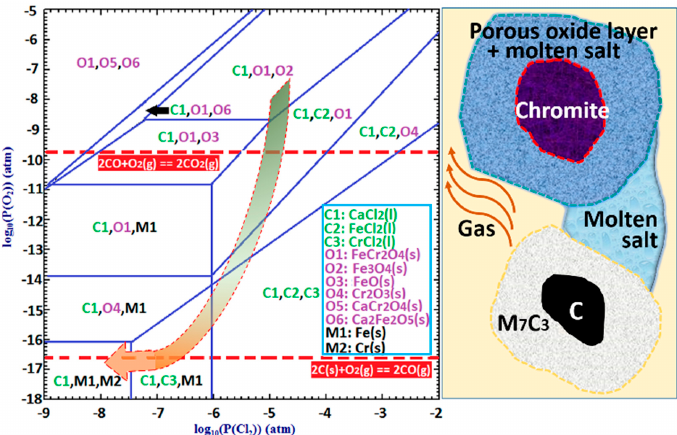
Figure 17. The presence of molten and/or gaseous CaCl 2 in the sample mixture maintained the chloridizing atmosphere that allowed the formation and transportation of volatile chlorides of Fe and Cr, before being reduced on the carbon particles forming ferrochrome alloy.